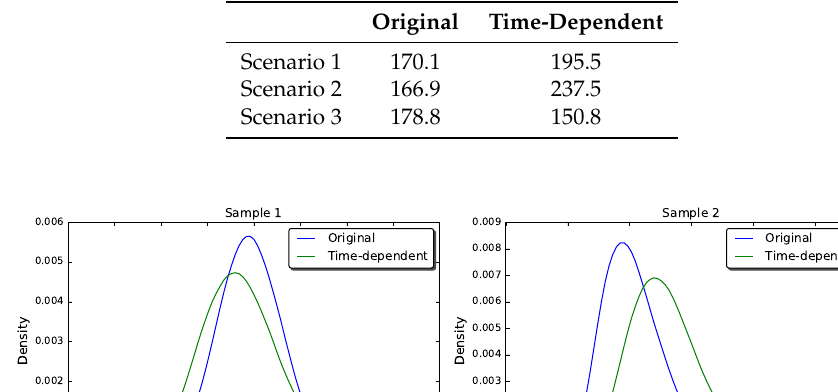
Table 5. Solvency Capital Requirement of the scenarios for the original and time-dependent risk-neutral measure.